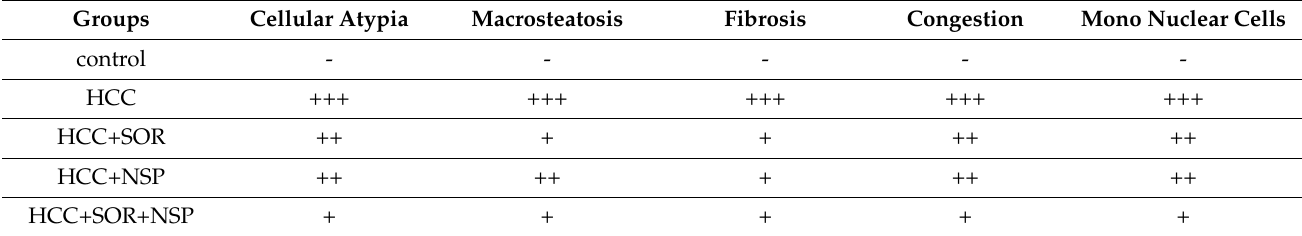
Table 4. Semi-quantitative analysis of morphometric changes in liver of different groups. Groups Cellular Atypia